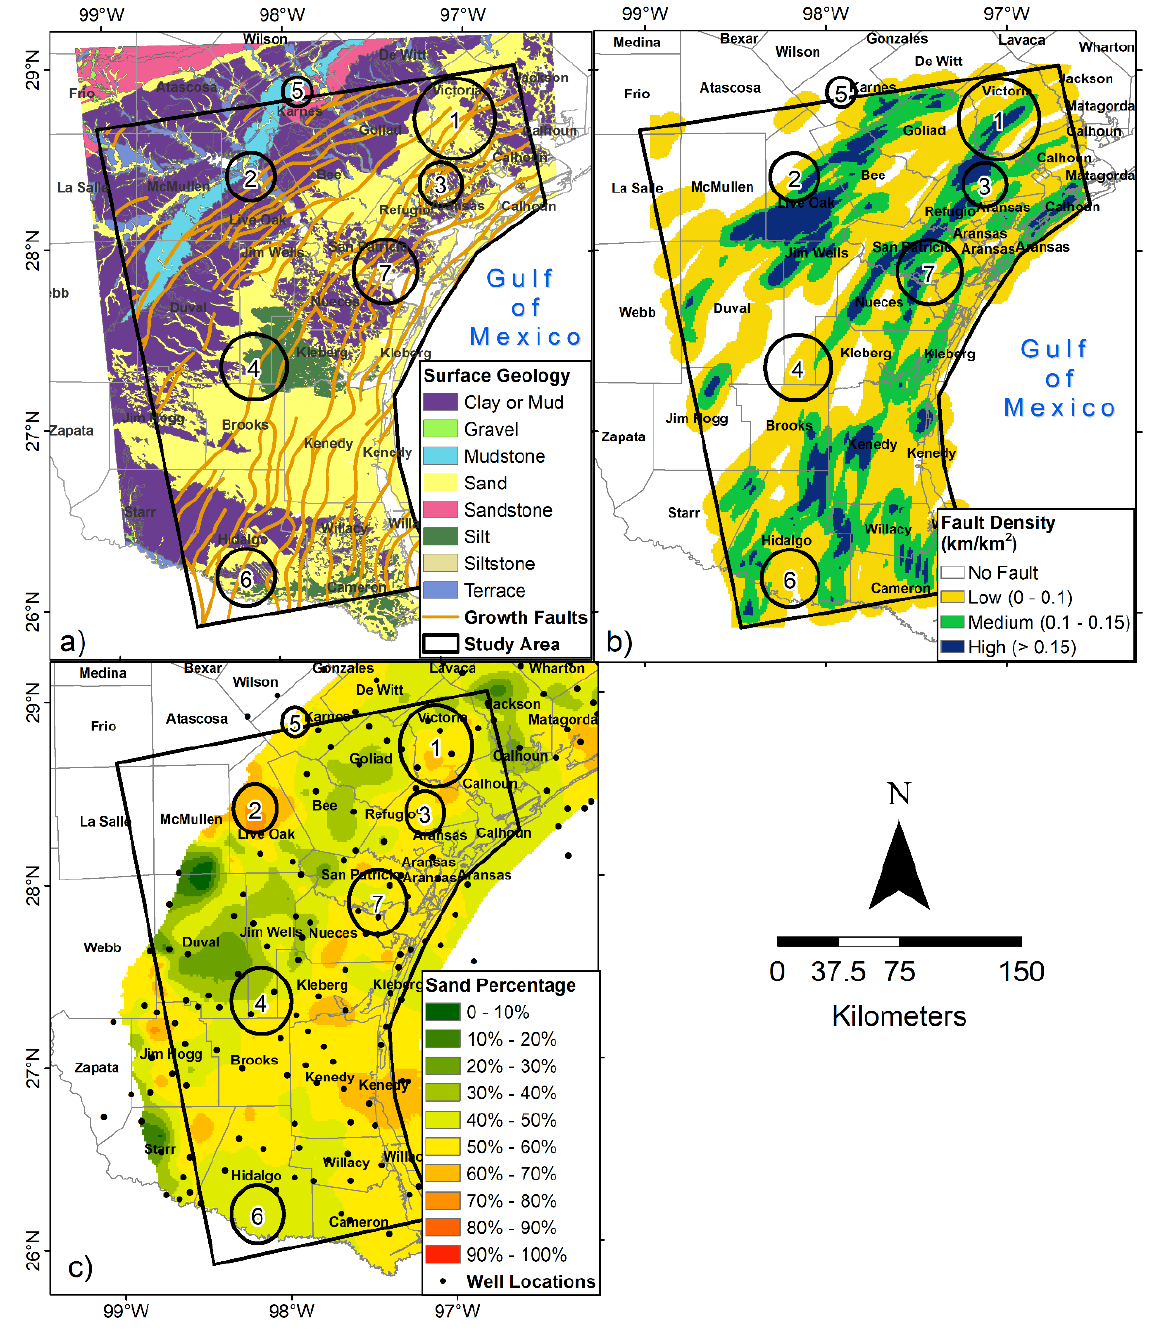
Figure 2. ( a ) Surface lithology within the Texas Coastal Bend region; also shown is the spatial distribution of growth faults (orange lines). ( b ) Growth fault density (in km/km 2 ) within the study area. ( c ) Spatial distribution of sand percentage, extracted from geophysical logs (black dots), within the GCA system. Circles 1–7 are areas that were identified to have witnessed a significant land subsidence during the investigated period (October 2016–July 2019).